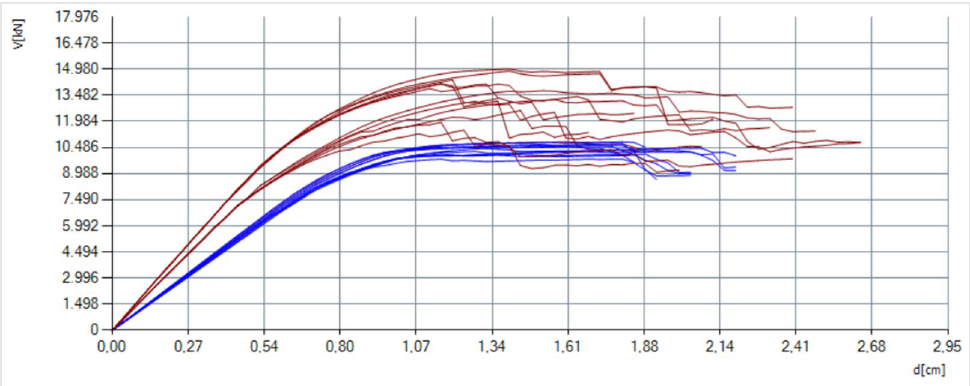
Figure 19. Capacity curves for the model strengthened by FRCM composite system for x (blue) and y (red) direction.